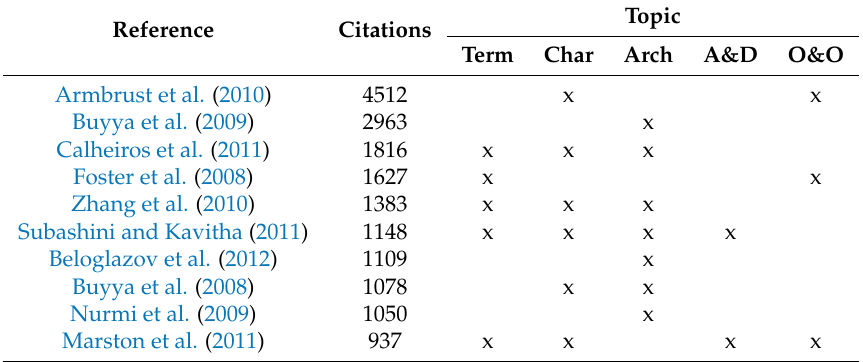
Table 11. Top most often cited core references in research on cloud computing by a topic. Topic Reference Citations Term Char Arch A&D